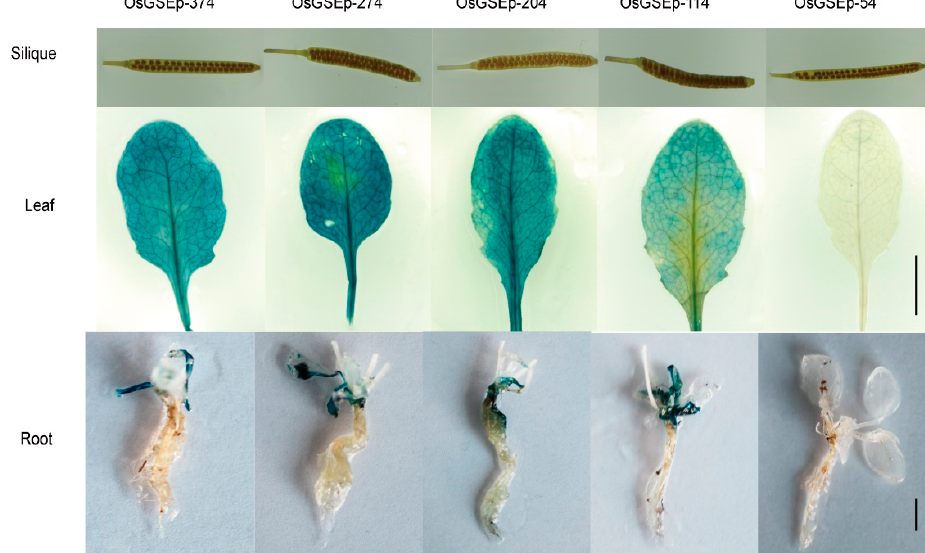
Figure 4. GUS staining in siliques, leaves and roots sampled during the reproductive stage from transgenic T3 Arabidopsis seedlings carrying OrGSEp-374, OrGSEp-274, OrGSEp-204, OrGSEp-114 and OrGSEp-54.Bar = 1 cm.